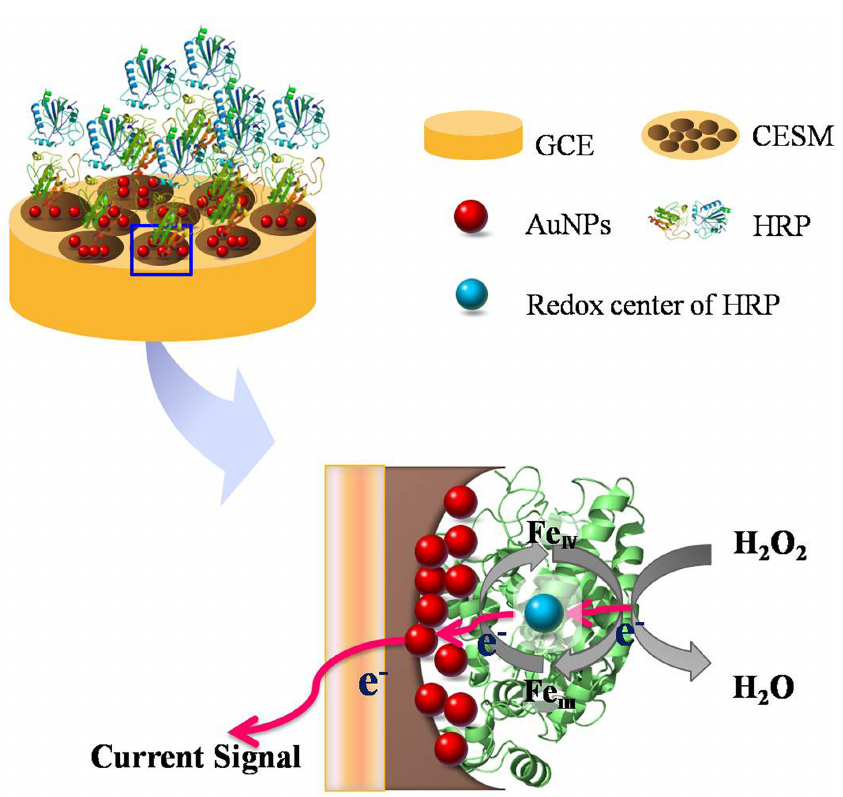
Fig 1. Schematic illustration of the mechanism underlying the detection of H 2 O 2 using HRP-AuNPs- CESM-GCE electrochemical biosensor.